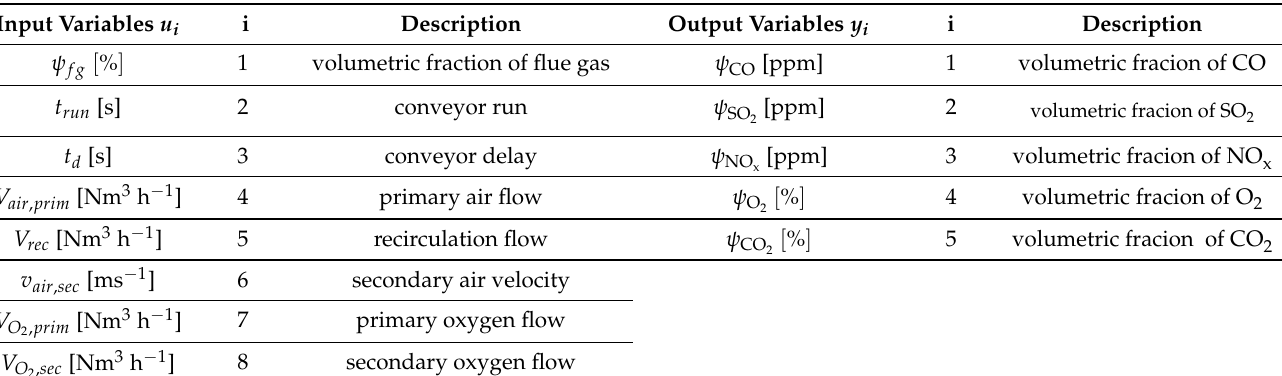
Table 1. Input and output variables used in the article were measured on the laboratory device, see Section 2.2. Notice, the previous values of the output variables y i ( i = 1 − 5 ) can also be in the state vector. Input Variables u